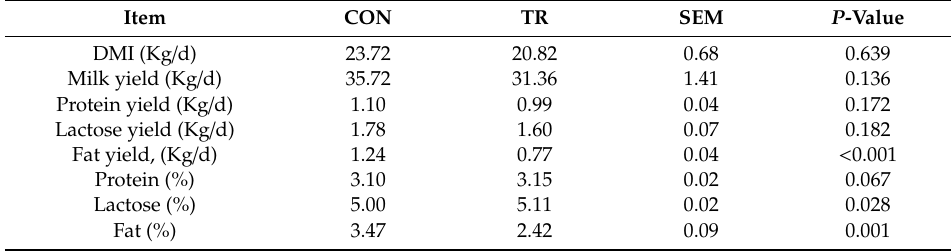
Table 1. Dry matter intake and milk component yields and concentrations of control (CON 1 ) and treatment (TR 2 )